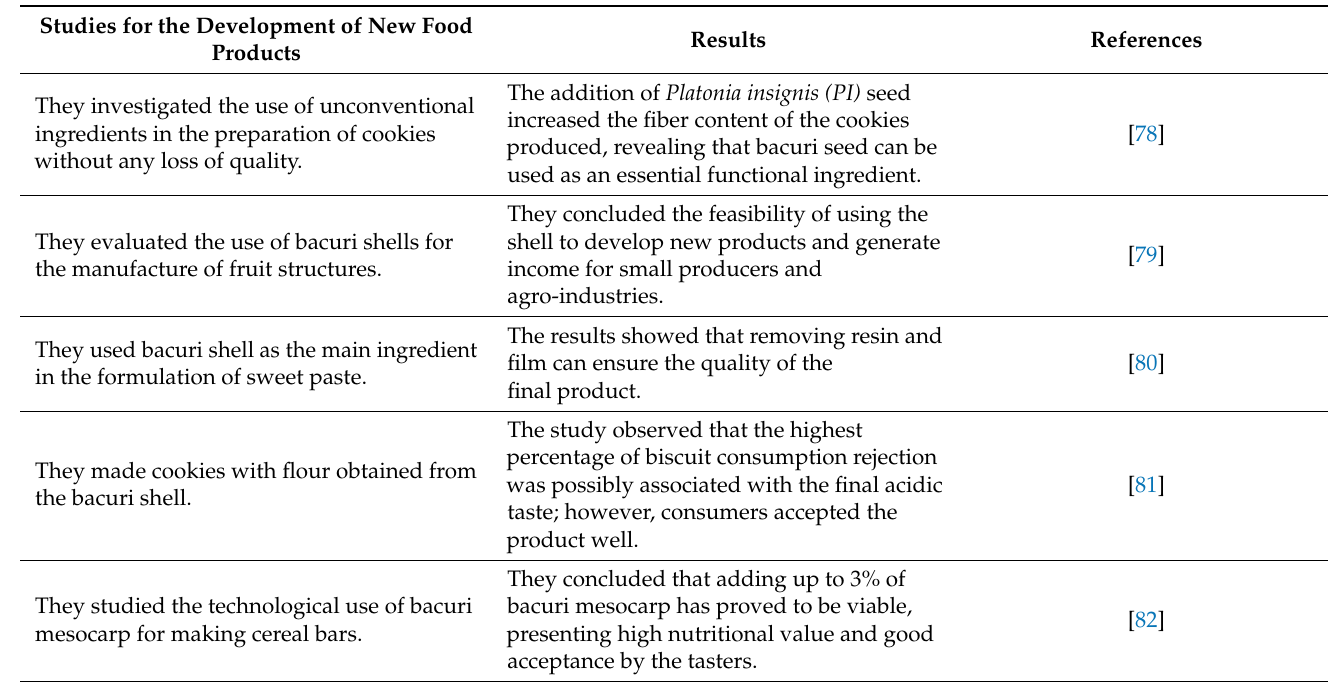
Table 9. Published studies using bacuri co-products ( Platonia insignis) in the development of food